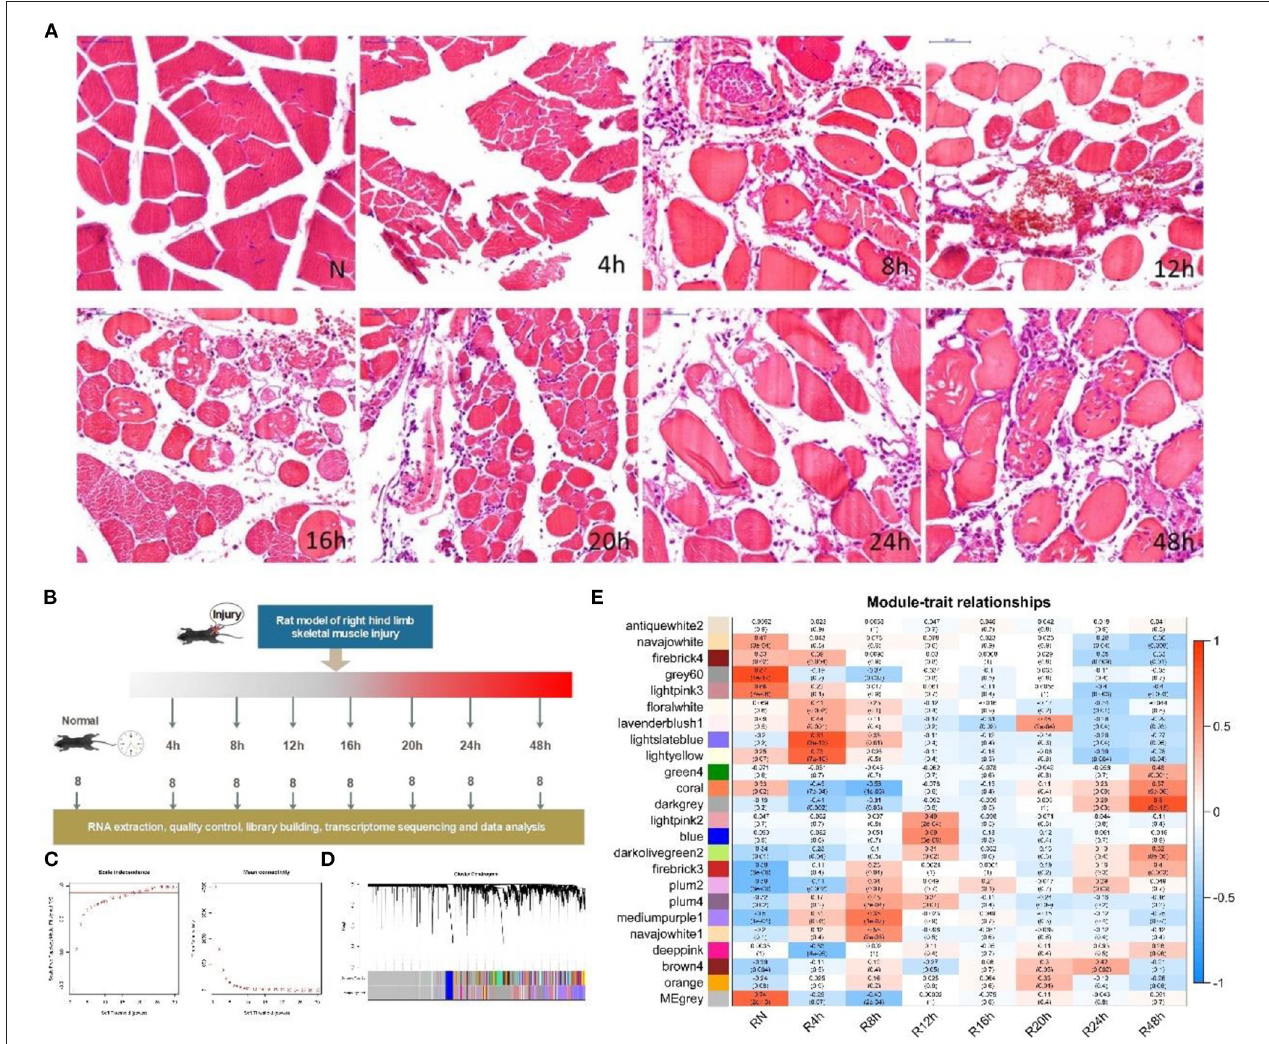
FIGURE 1 | Experimental design, histological characteristics and gene co-expression module division according to WGCNA during the early period after SMI. (A) Animal model design. Sixty-four male Sprague Dawley rats were randomly divided into eight groups ( n = 8 rats/group; seven experiment groups and one control group). Experimental rats underwent a SMI in the right hind limb and were monitored at 4, 8, 12, 16, 20, 24, and 48h after injury. (B) H&E staining was performed to reveal the characteristics from injury to repair. The SMI repair process in the right hind limb in seven experimental groups (4, 8, 12, 16, 20, 24, and 48h post-injury) and the normal group was histologically evaluated in transverse sections. Scale bar: 50 µ m. (C) Relationship between soft power and network connectivity. Based on the scale-free network (y-axis, R 2 = 0.94) with a soft threshold set to 22 and the mean connectivity value, the network exhibited negligible connectivity. The networks exhibited a scale-free network distribution. (D) Network cluster dendrogram. The network was divided into 24 co-expression modules each of which was assigned a color. The color gray was assigned to genes that did not cluster into a specific module. (E) Correlation between consensus modules and sample traits in each module. Red indicates a positive correlation, with a darker color indicating a stronger correlation. The top number in each cell indicates the correlation coefficient, and the bottom number indicates the significance of the correlation (i.e., the p